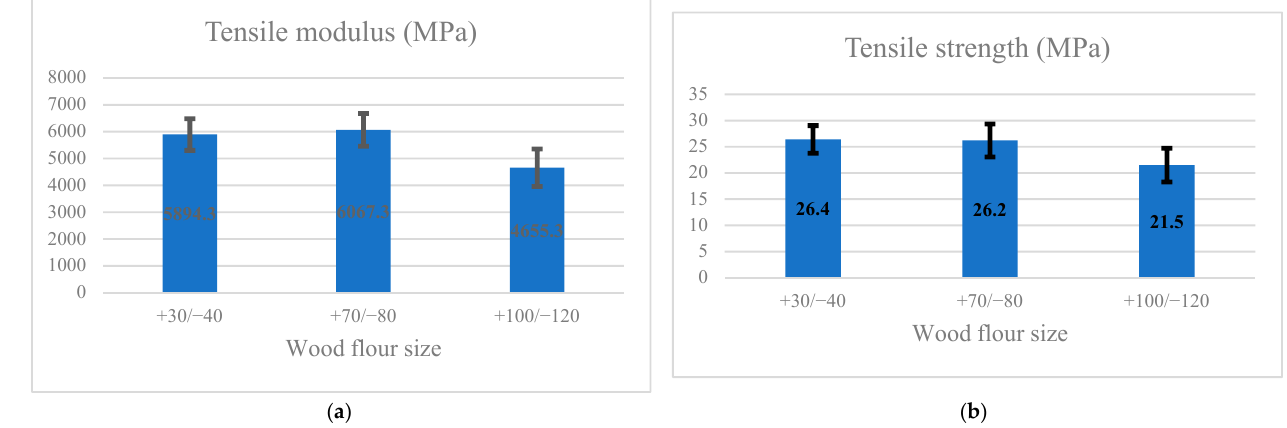
Figure 3. Impact of wood flour size on tensile ( a ) modulus; ( b ) strength. Figure 4a,b shows the effect of flour dimensions on the flexural modulus and strength, respectively. Black lines represent the one measure of standard deviation. Following the Duncan test, the maximum flexural modulus was related to the samples made of +100/ − 120 powder (4007.7 MPa), and the minimum in group A was connected to the specimens made of +30/ − 40 flour size (3795.3 MPa). According to Duncan’s test grouping, the maximum flexural strength in group A was related to samples made of +70/ − 80 size (49.1 MPa). The minimum in group b was connected to specimens made of +30/ − 40 (45.9 MPa) and +100/ − 120 (45.3 MPa) flour size.